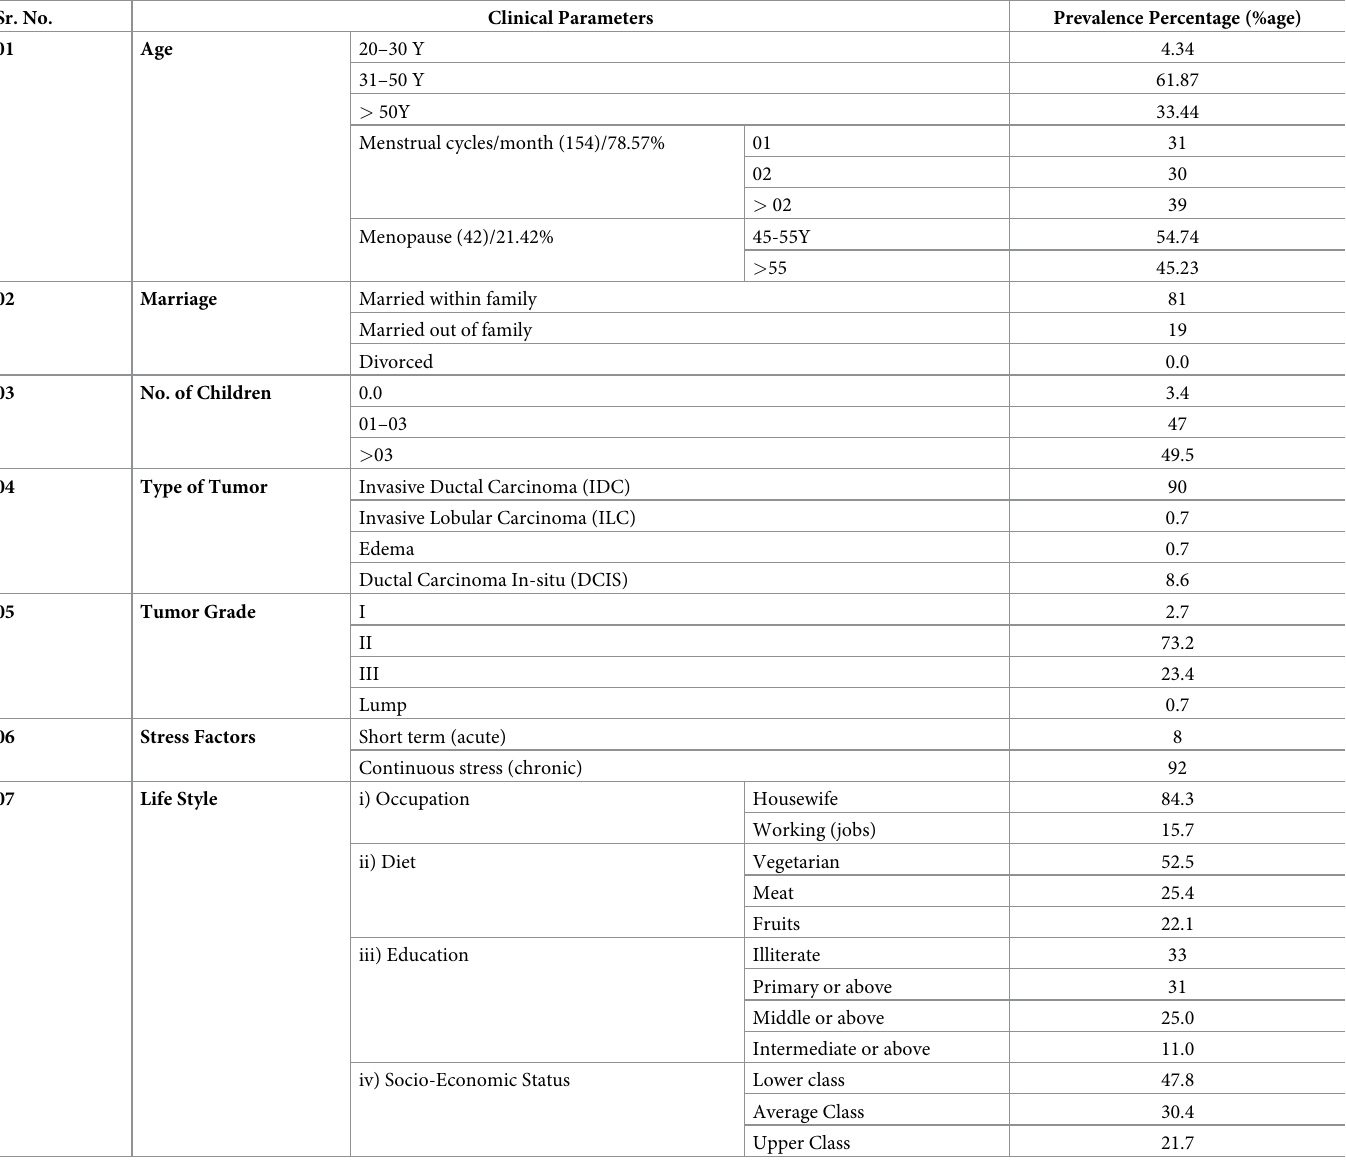
Table 1. Prevalence of different clinical parametres in breast cancer patients (n = 299). Sr.